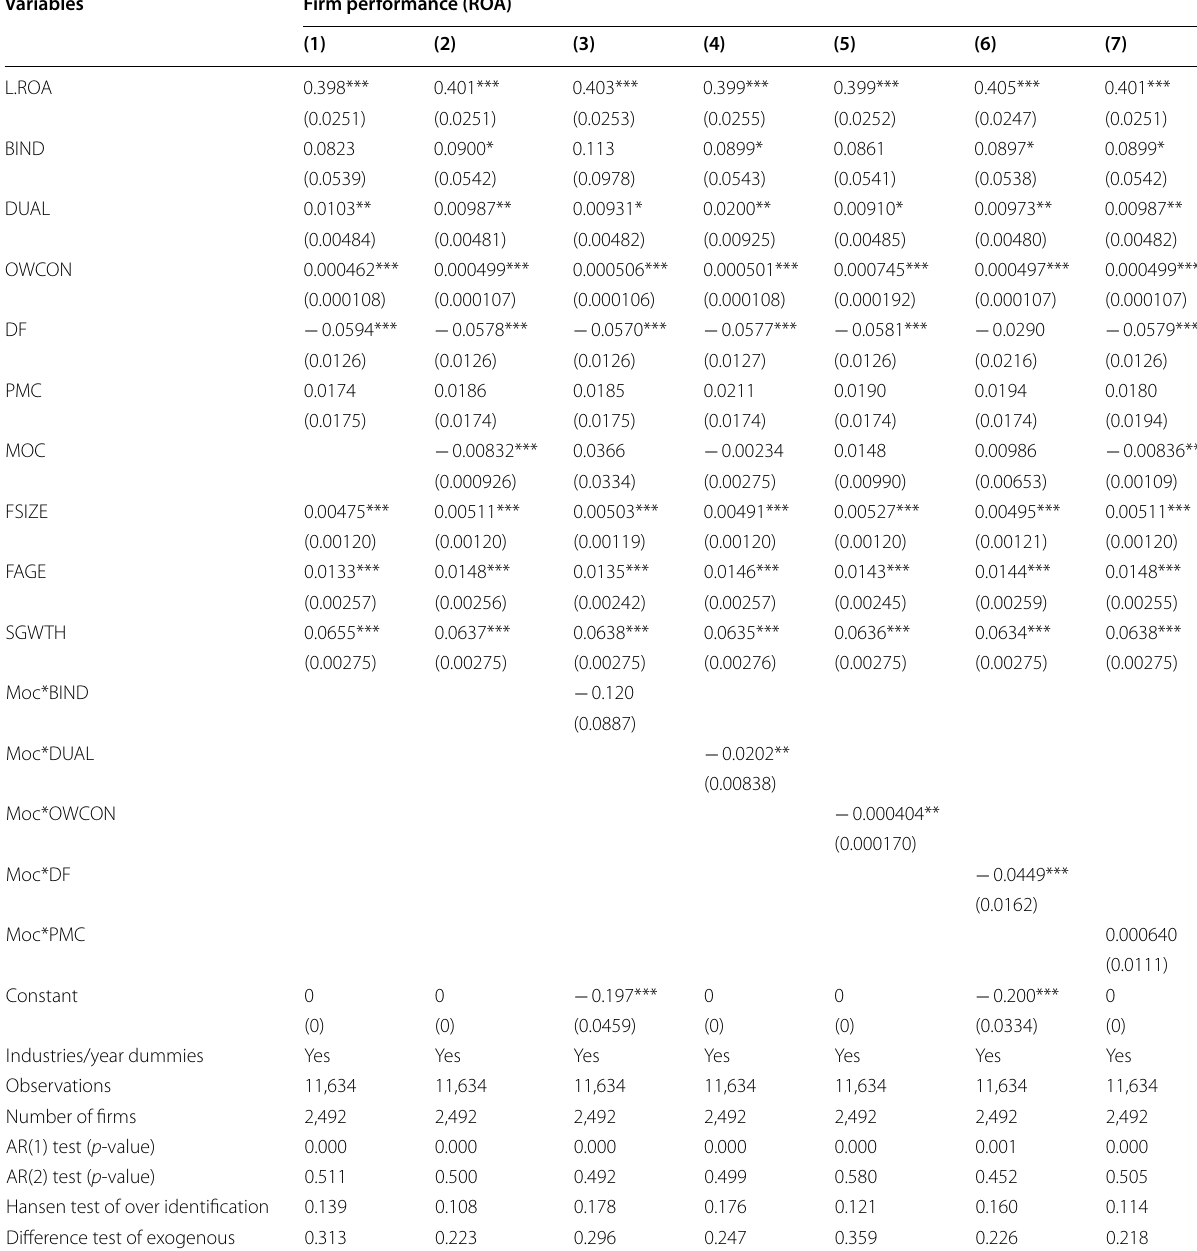
Table 3 Regression results of influences of managerial overconfidence in the relationship of corporate governance mechanisms and firm performance